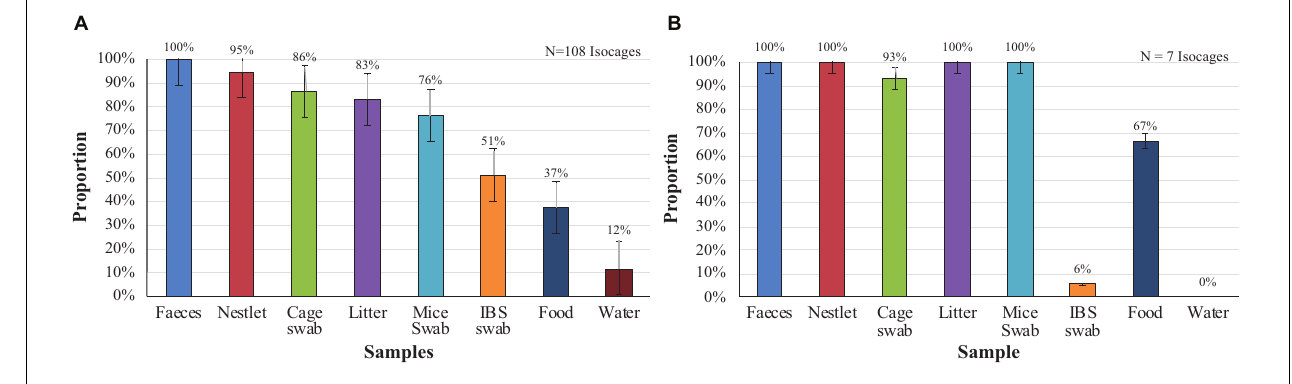
FIGURE 1 | Proportion of positive samples per culture when non-axenic and accidentally contaminated axenic mice are introduced into sterile cages after two weeks. (A) Non-axenic mice. (B) Accidentally contaminated mice.